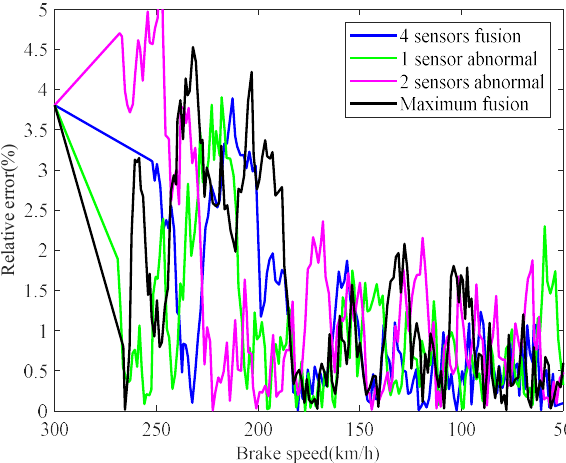
Figure 13. Identification relative errors of friction coefficient.